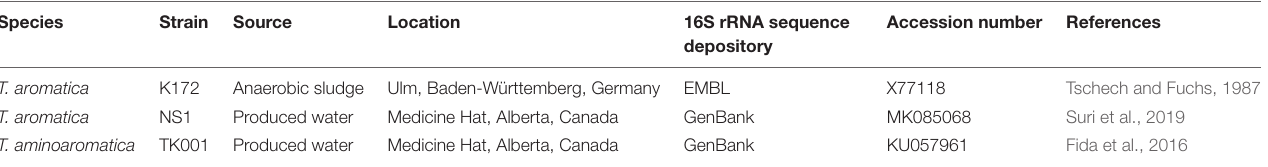
TABLE 1 | Description of denitrifying Thauera strains used to inoculate microcosms in this study.